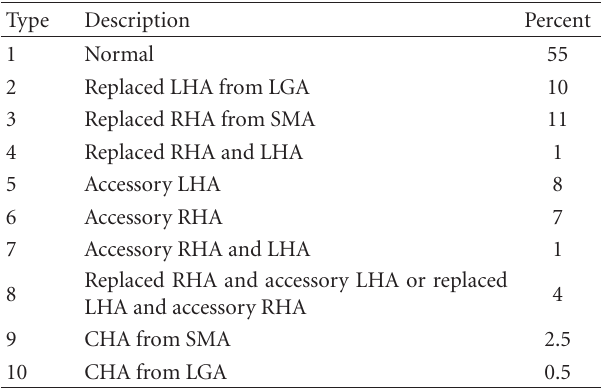
Table 1: Michels’ classification of hepatic arterial anatomy.